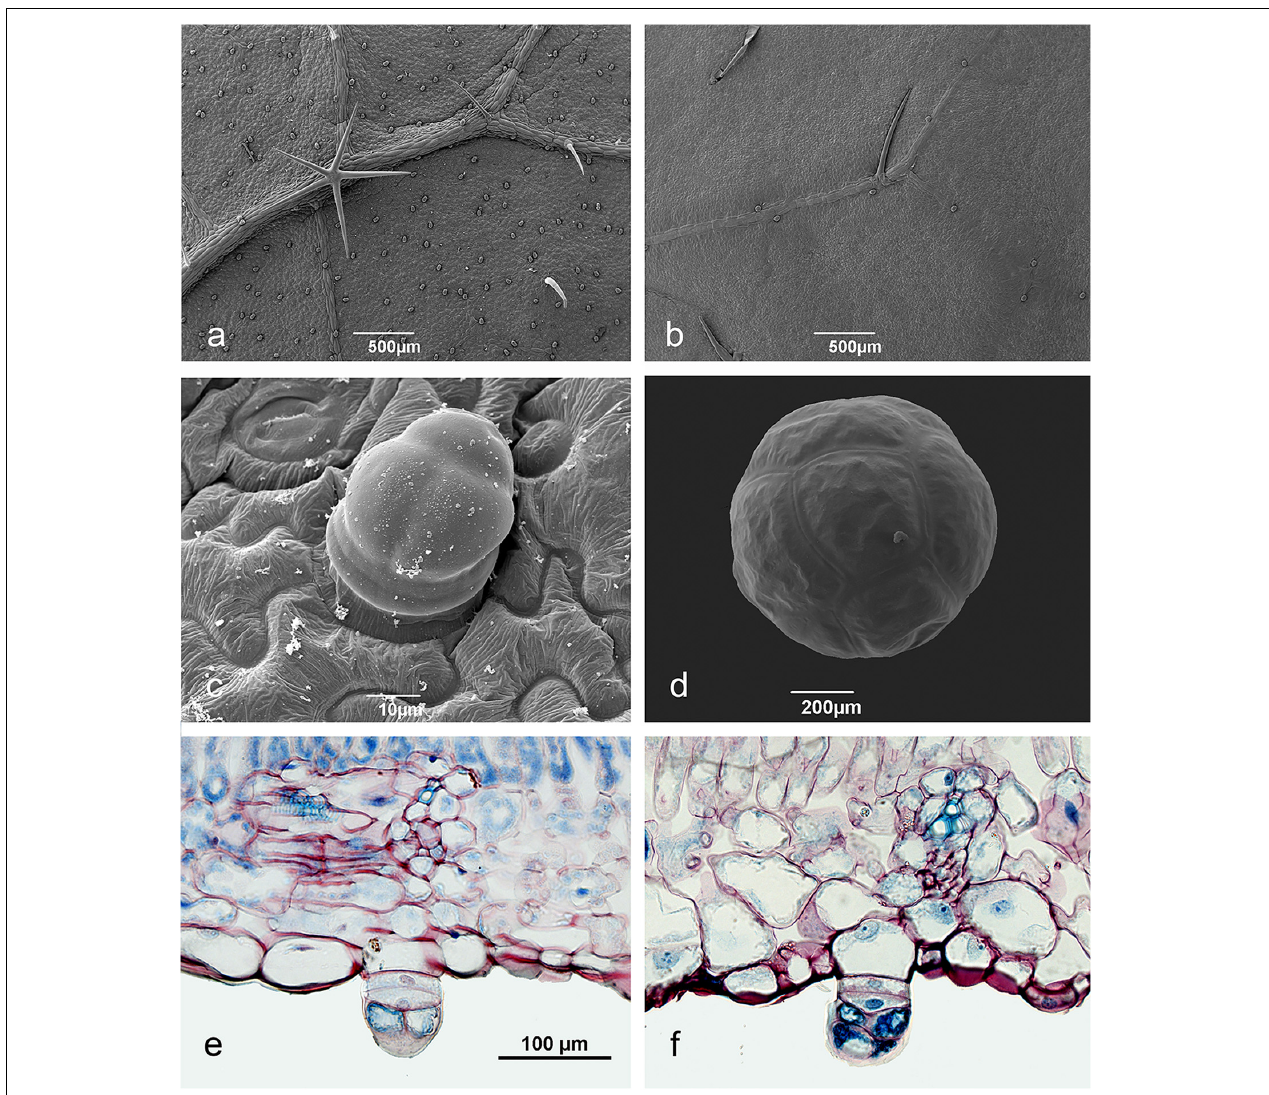
FIGURE 4 | Pearl body structure in Okra varieties. (a,c) lower leaf surface of Clemson young leaf, (b) upper leaf surface Clemson young leaf, (d) mature pearl body from a Hire leaf, (e,f) longitudinal leaf sections of Paysan (e) , and Clemson (f) with pearl bodies developing on the lower leaf surface. The initial epidermis cell, the two stalk cells and the apical cells dividing anticlinally can be